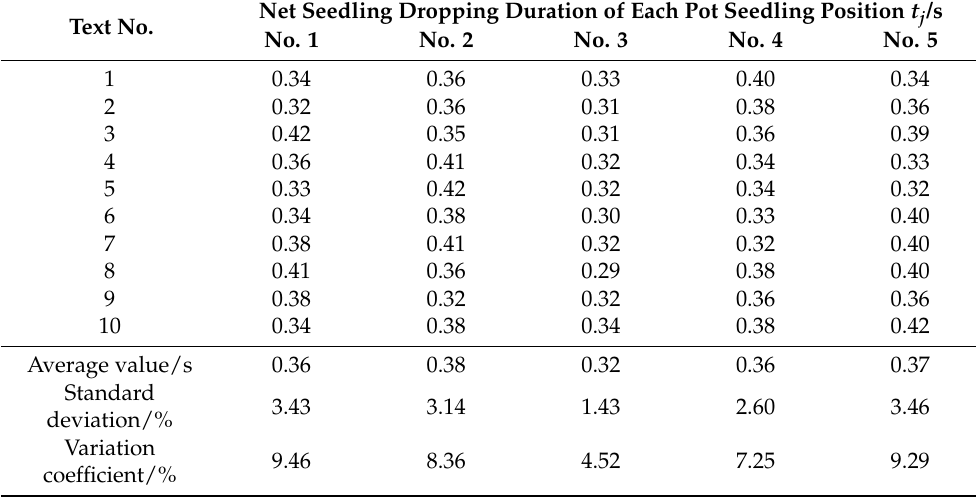
Table 1. Net seedling dropping duration test